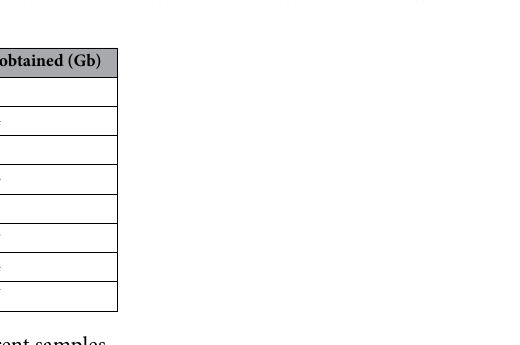
Figure 2. Growth of Arabidopsis thaliana in presence of RAR under phosphate starved condition in the hydroponic system ( A ); Circos showing the histogram of genes mapped onto 5 chromosomes of Arabidopsis thaliana ( B ). Venn diagram showing total number of expressed transcripts ( C ); Venn diagram of the differentially expressed upregulated ( D ) and downregulated genes ( E ) in RAR, HA and HA + RAR treatment as compared to control.